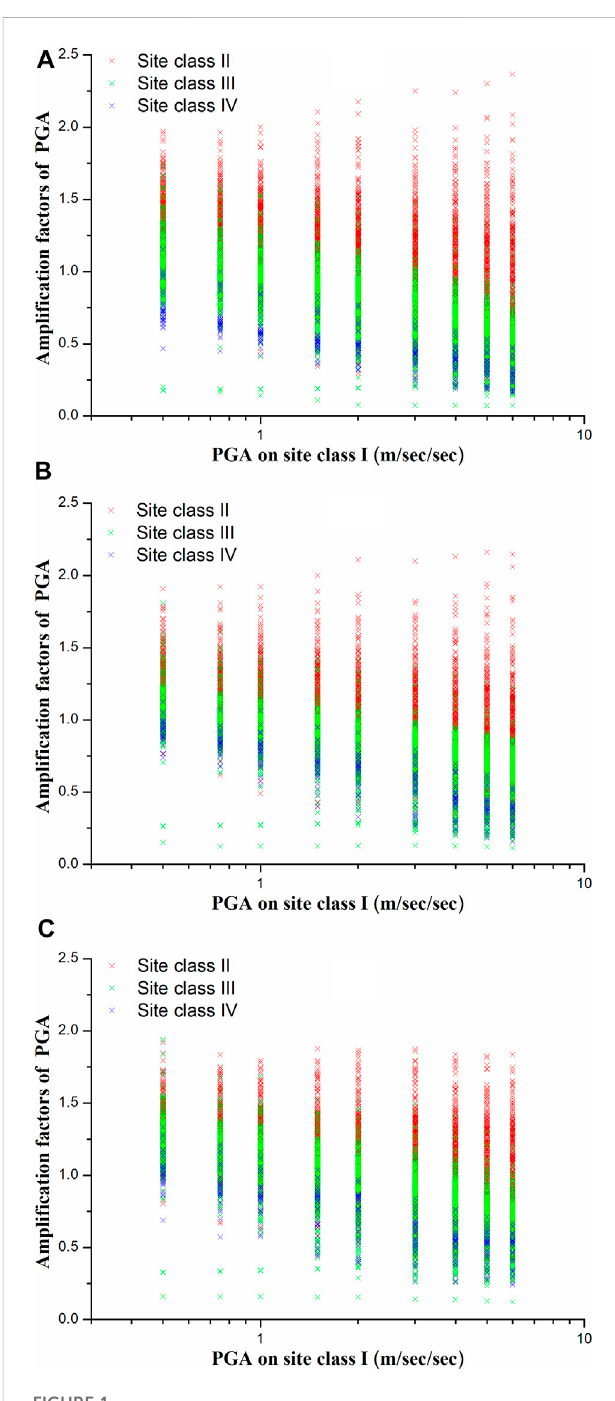
FIGURE 1 PGA ampli fi cation factors on site class II, III, and IV versus on site classI 0 givenbyboreholenumericalsimulationswhenthemotioninputs of subterrane bottom interface were arti fi cial acceleration time series synthesized according to the average PGA-normalized Sa for (A) – 6.0, (B) M – 7.0, and (C) M – M W = 5.0 W = 6.0 W = 7.0